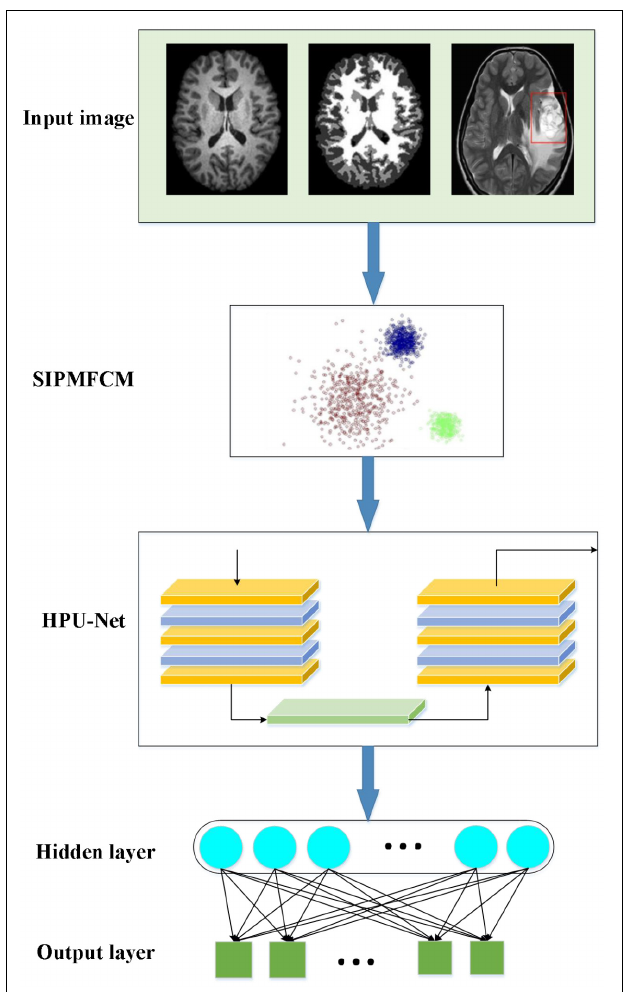
FIGURE 4 | A demonstration to the brain image processing and brain disease diagnosis prediction model based on fuzzy clustering and HPU-Net.